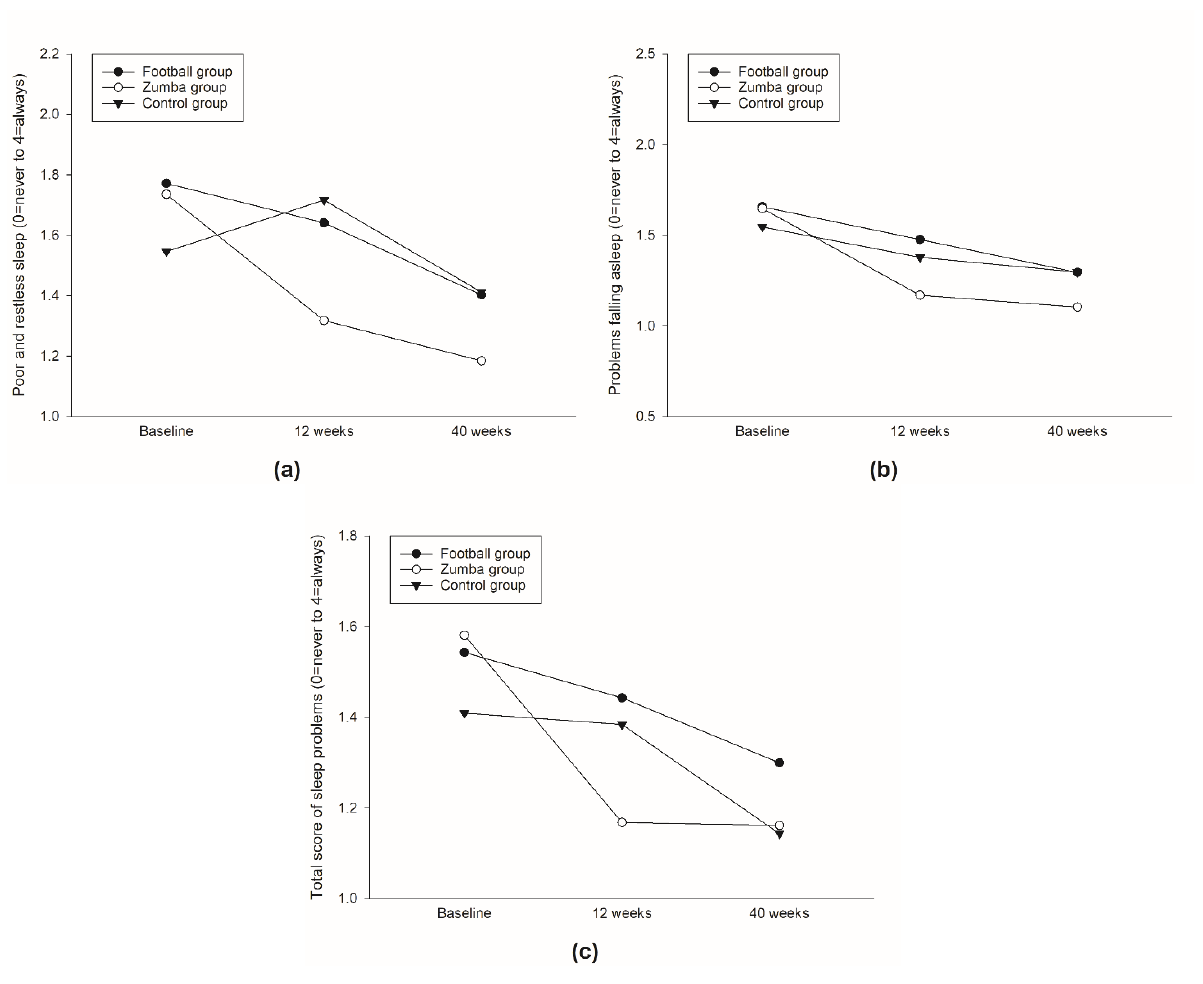
Figure 4. Between-group differences over 12 and 40 weeks in self-reported frequency of poor and restless sleep ( a ); frequency of problems falling asleep ( b ); and total score of sleep problems ( c ). Furthermore, similar tendencies for between-group differences in the overall mean (on 0–4 scales) in favor of the Zumba group compared with the controls were revealed in the frequency of problems falling asleep ( − 0.17, 95% CI − 0.33 to 0.00, p = 0.055) (Figure 4b), as well as in the total score of sleep problems ( − 0.14, 95% CI − 0.29 to 0.00, p = 0.051) in the past three months (Figure 4c) over the 40-week intervention period. In the Zumba group these tendencies were supported by significant within-group reductions in both the frequencies of problems falling asleep ( p < 0.001) and total sleep problems ( p < 0.001) between baseline and 12 weeks and 40 weeks (Table 2). No between-group differences in either poor and restless sleep or in the total score of sleep problems in the past three months were observed in comparison to the football group and the controls (Table 2). However, the football group revealed significant within-group reduction in the frequency of problems falling asleep between baseline and 40 weeks ( p < 0.05), without any improvements related to total score of sleep problems (Table